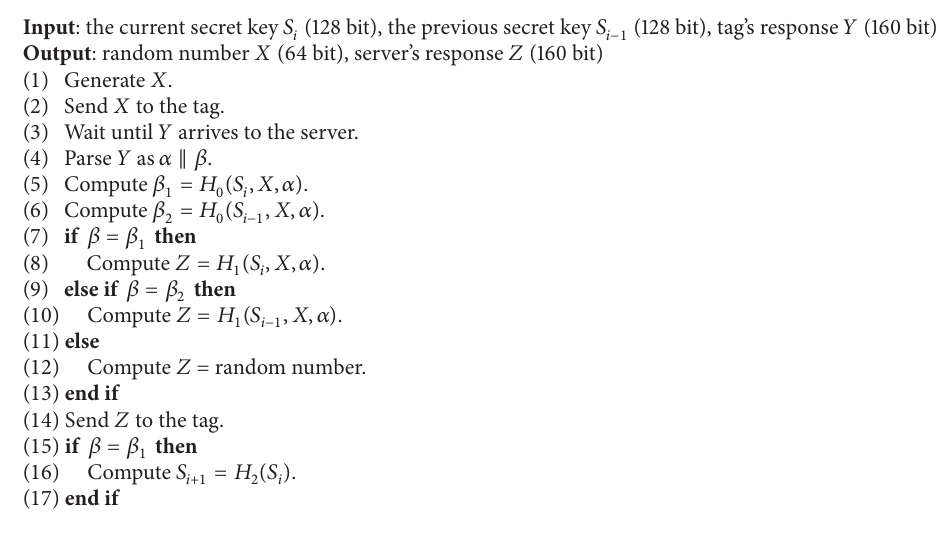
Algorithm 1: Authentication process of the